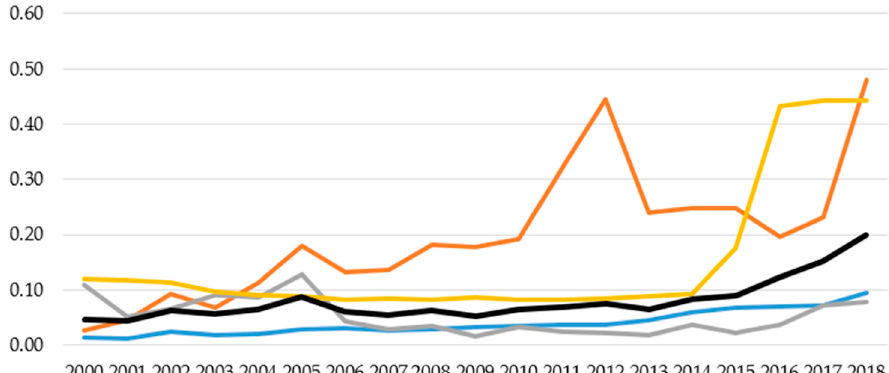
Figure 18. Dynamics of the structural components of the index of economic security in China: blue line–social security index, orange–industrial and service security index, grey–financial and macroeconomic security index, yellow–resource index, and black–economic security index.